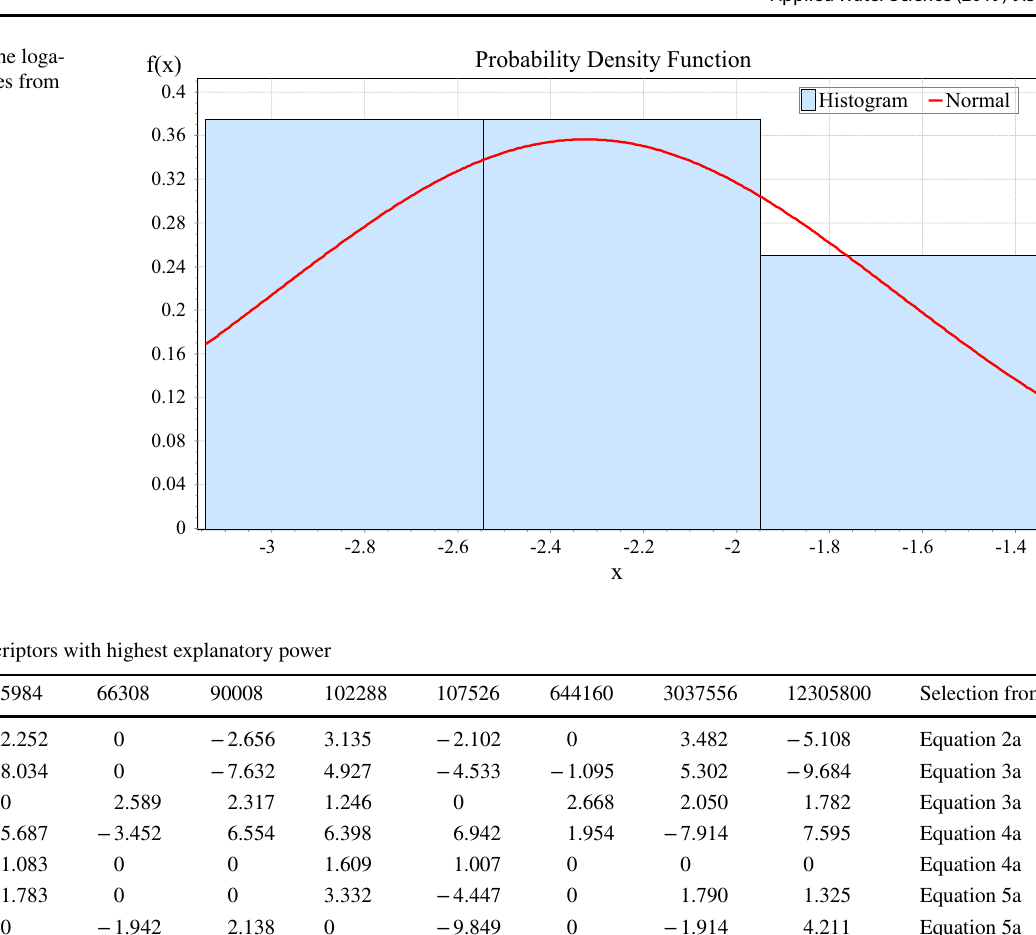
Histogram Normal